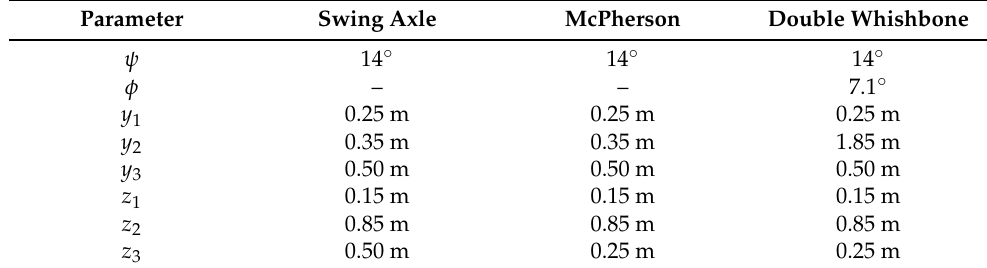
Table 1. Geometrical parameters used for model validation. Parameter Swing Axle McPherson Double